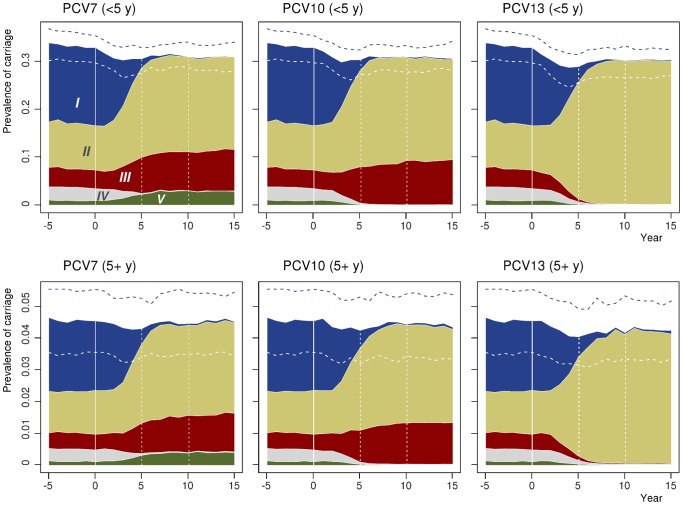
Impact of vaccination on pneumococcal carriage in two age classes in Finland.Each panel presents the projected cumulative prevalence of carriage of the five serotype categories (from V to I) as a function of time, with time 0 corresponding to the onset of the vaccination programme. The point-wise median prevalence based on the 50 most optimal parameter combinations is shown cumulatively by serotype category. For the total prevalence of all five categories, also the 5% and 95% quantiles (dashed curves) are shown. Upper panels: individuals <5 years of age. Lower panels: individuals 5+ years of age. From left to right: PCV7, PCV10, PCV13. To adjust for a changing demography, the prevalence shown in the figure is standardised according to the age distribution of Finland in 2005. In the simulation, the values of vaccine efficacy against carriage (φc) was 0.50 for all vaccine types in the respective vaccine formulation, the coverage of vaccination (pc) 0.90 and the waning rate of immunity against carriage (w) 10% per year.